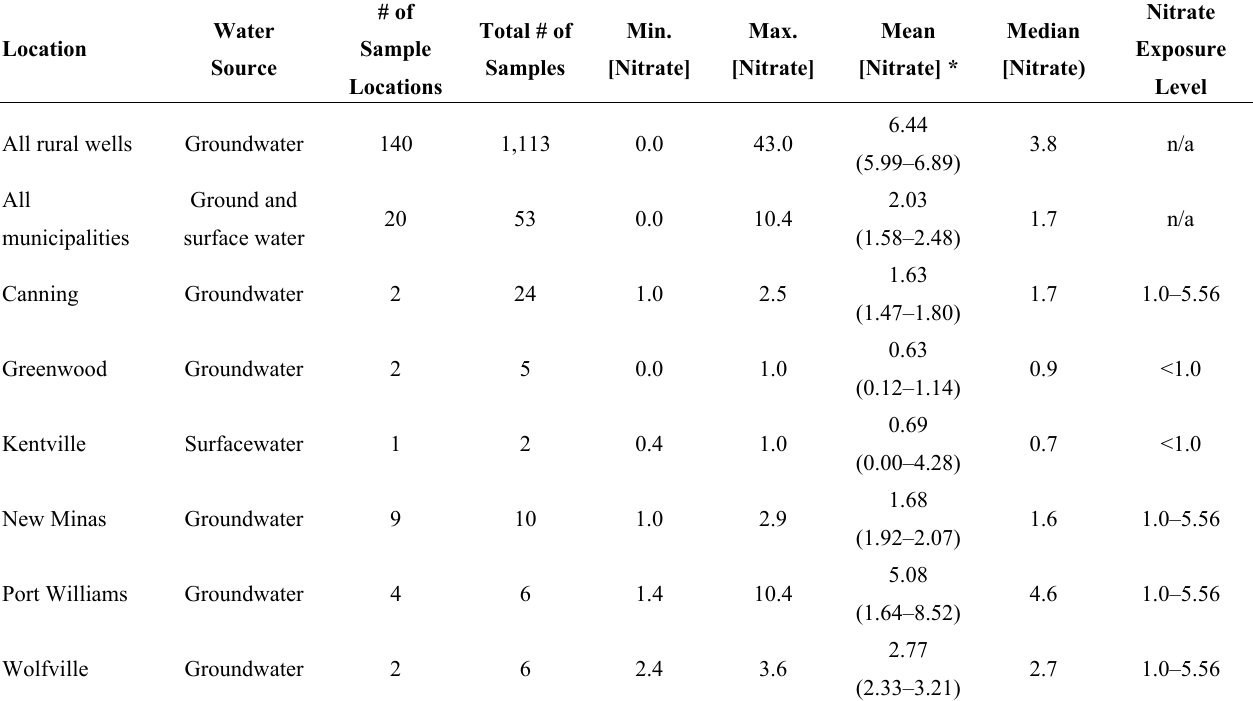
Table 1. Descriptive statistics of nitrate-nitrogen concentrations (mg/L) for all water sources in each municipal water supply from 1996 to 2003 in comparison to all sampled rural wells in Kings County from 1999–2000. Nitrate exposure level refers to the nitrate concentration categorization used in subsequent analyses to determine the association between congenital anomalies and nitrate